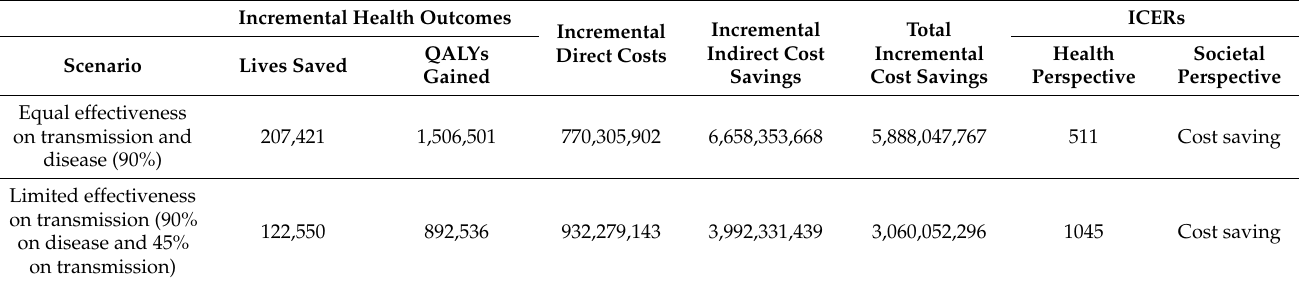
Table 3. Incremental health outcomes, costs and resulting ICERs for the two vaccination scenarios against the baseline from the healthcare and societal perspectives (all costs are in USD, and a discount rate of 3% was used for the QALYs).